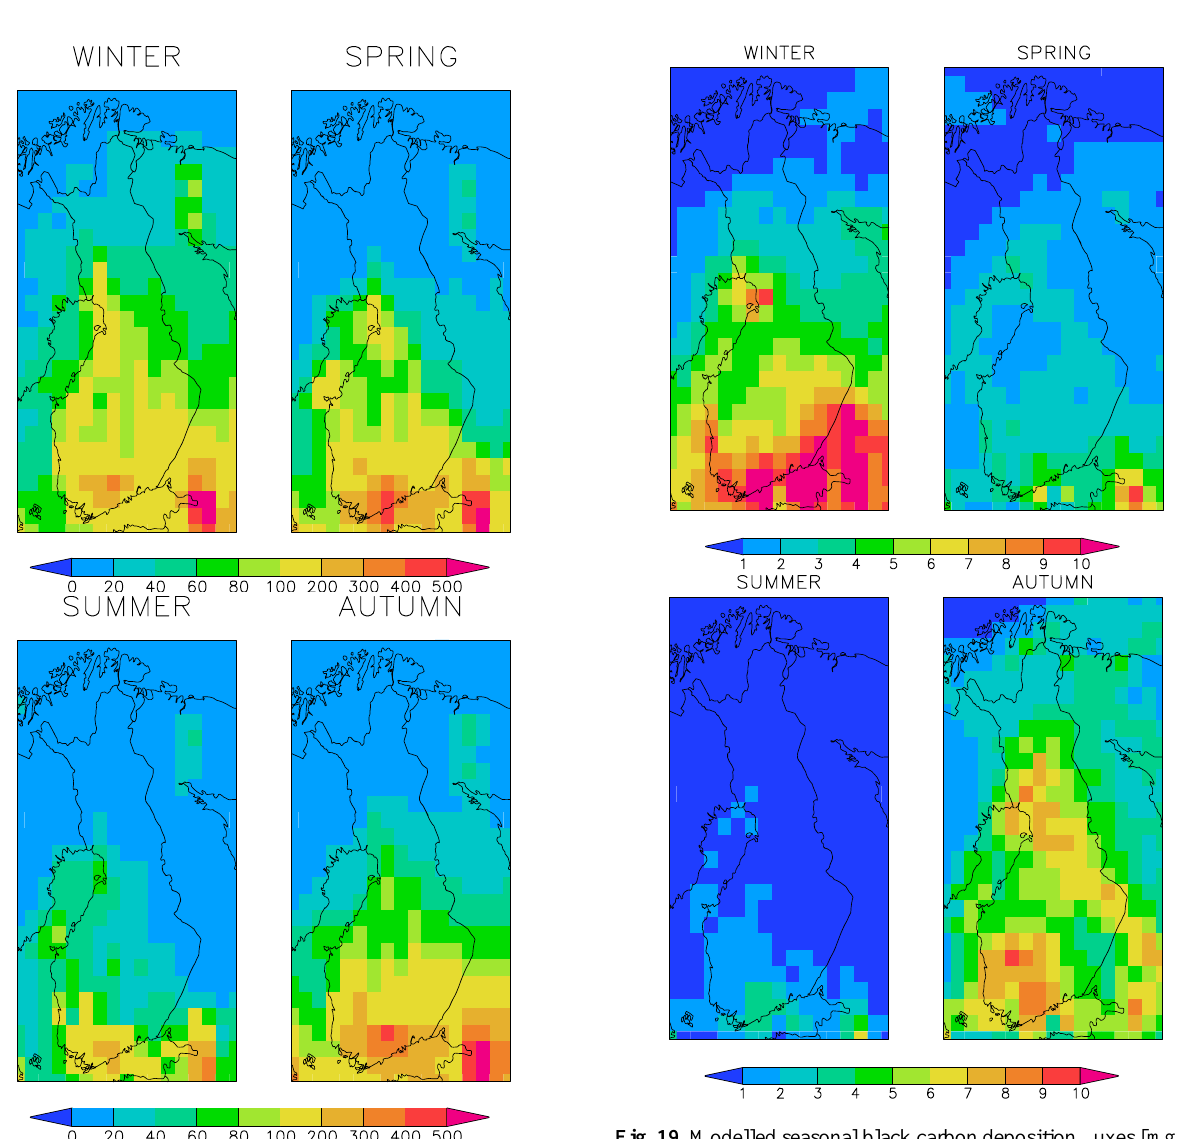
Fig. 19. Modelled seasonal black carbon deposition fluxes [mg/m 2 ] over Finland for